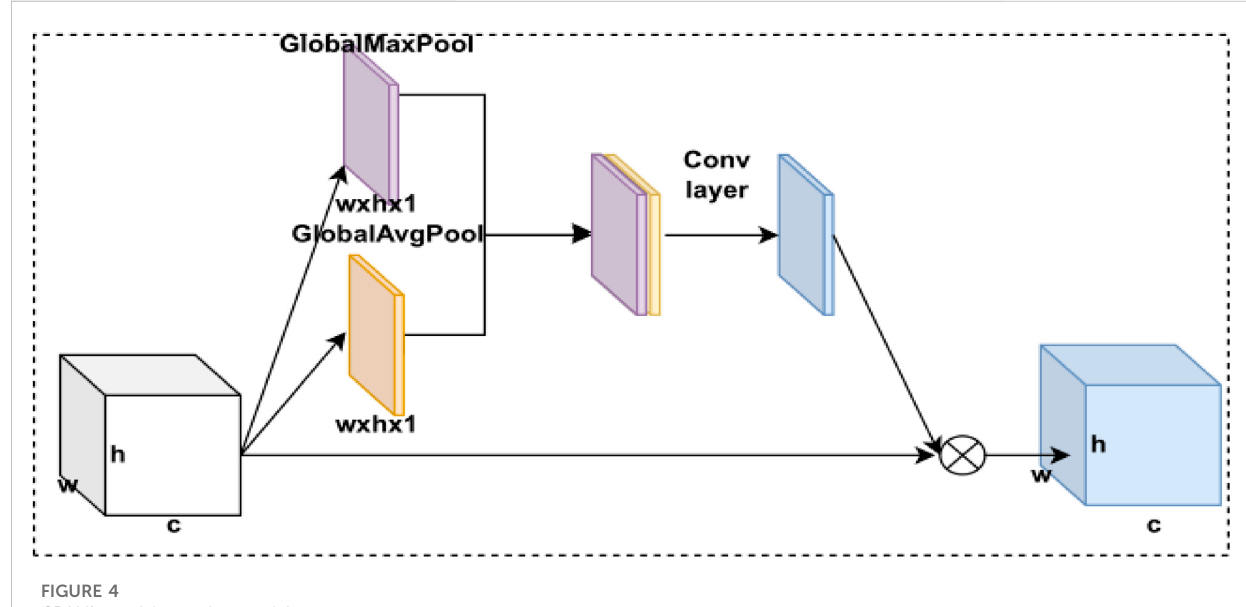
FIGURE 4 CBAM ’ s spatial attention module